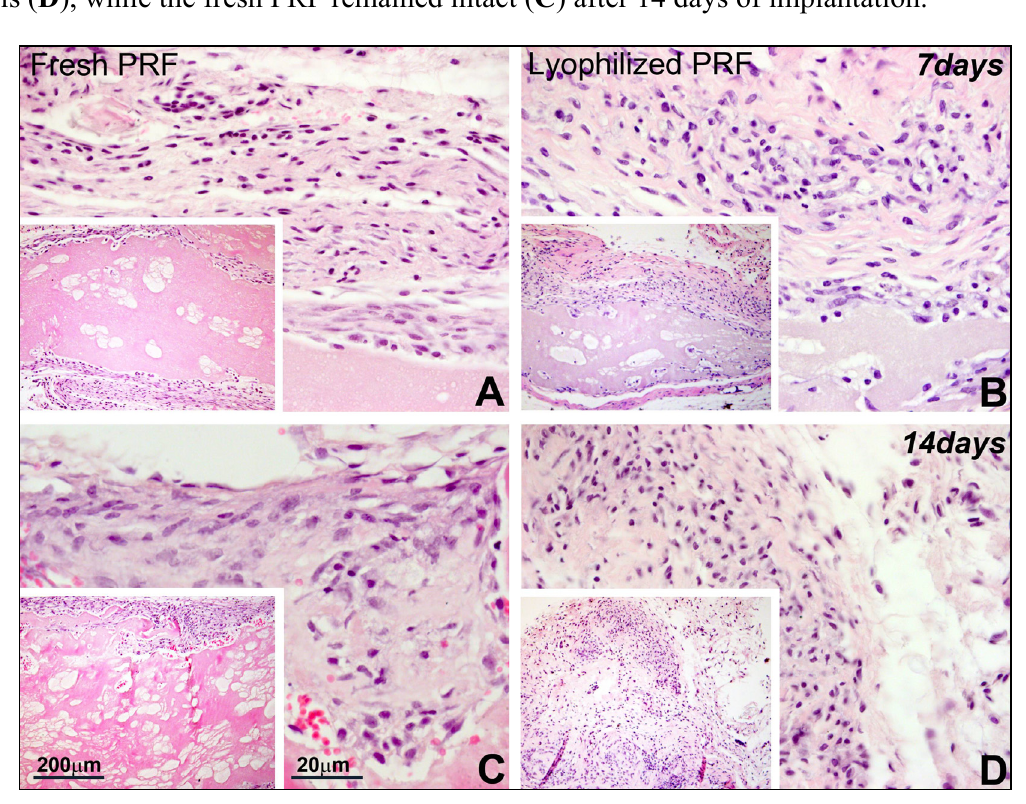
Figure 5. Comparison between lyophilized and fresh PRF in subcutaneous implants. Subcutaneous implants of fresh ( A , C ) and lyophilized PRF ( B , D ) were dissected from nude mice after seven days ( A , B ) and 14 days ( C , D ) of implantation. The samples were fixed and processed for paraffin sections and stained with hematoxylin and eosin. Note the loose and porous structure of the lyophilized PRF ( B ) when compared to fresh PRF ( A ) after seven days of implantation. The lyophilized PRF scaffold was infiltrated by fibroblast-like cells ( D ), while the fresh PRF remained intact ( C ) after 14 days of